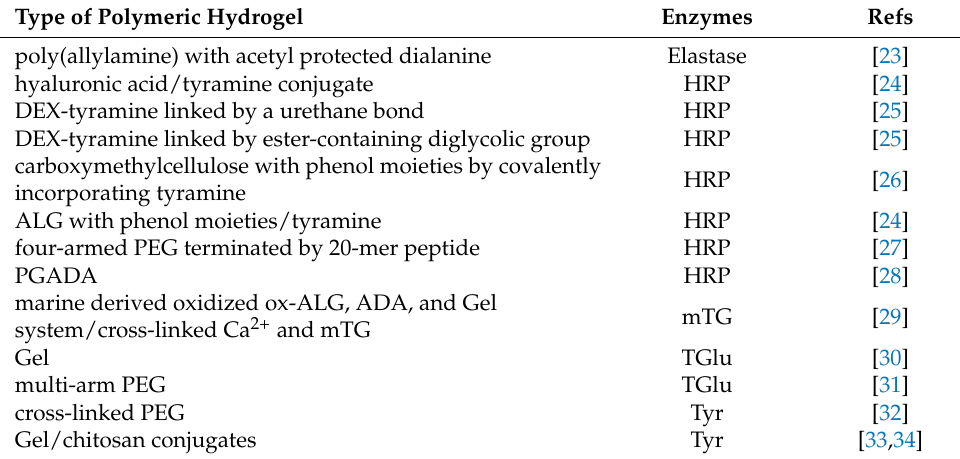
Table 1. Enzymes used in biomedical hydrogels